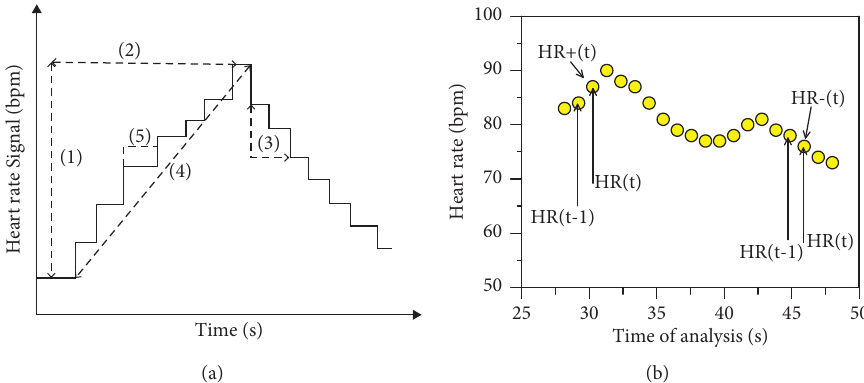
Figure 8: Heart rate analysis over the time of VR experiment: (a) procedure presented in [21] (figure reproduced under the terms and conditions of a CC-BY license) and (b) current